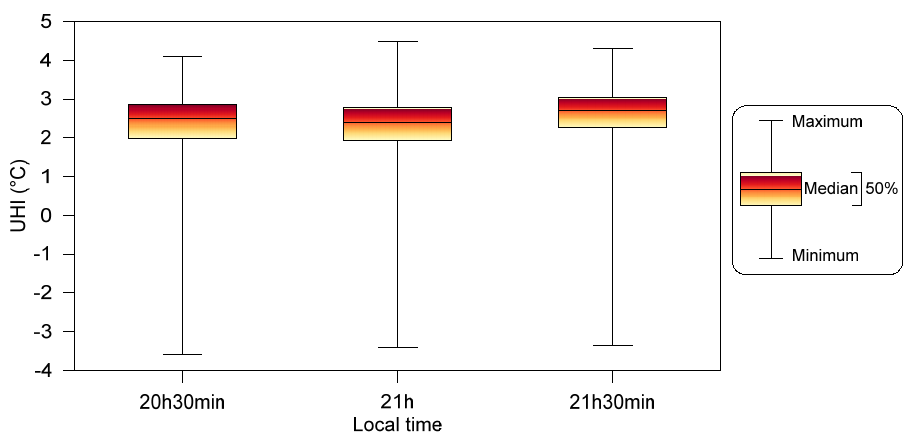
Figure 6. Boxplots of UHIs at 20:30, 21:00, and 21:30.